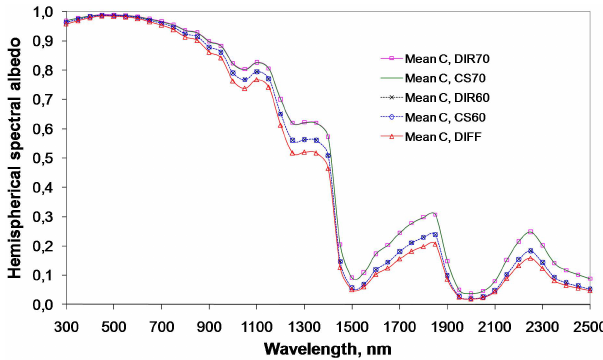
Fig. 15. Hemispherical spectral albedo of the mean group C snow pit, calculated with all light sources of Table